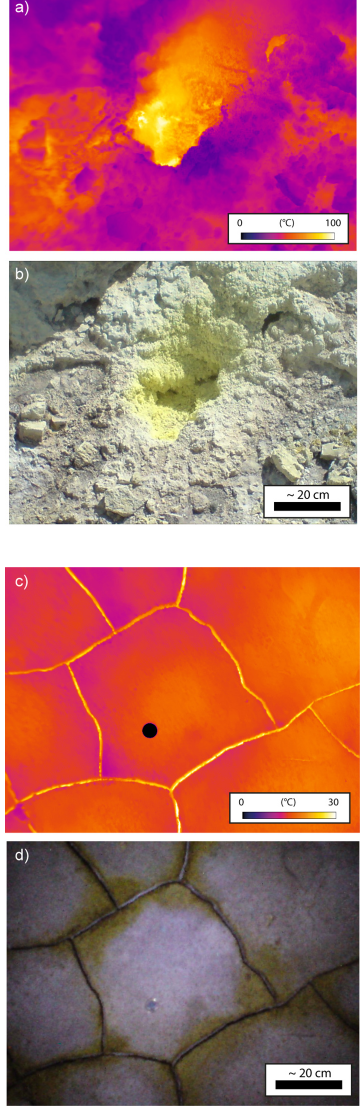
Fig. 5. (a, b) IR and OP close-ups of a fumarole on the western mound. The IR image shows that the temperature at the vent reaches 100 ◦ C, according to direct measurements. This is possible as the pixel size is sub-mm. It also shows that temperature rapidly de- creases sideways. The same can be deduced by the OP, where solid sulfur exists close to the degassing vent. (c, d) IR and OP close-up of the dessication polygon. The IR image shows the plate as cool, whereas the bounding fracture is ∼ 5 ◦ C warmer. The black circle is a 1 Euro coin for scale; it appears cooler because it has an emis- sivity different from the emissivity of the soil. The OP image shows the sulfur crystallization close to the fracture.